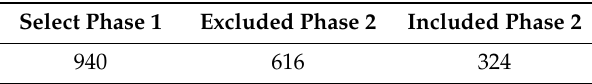
Table 3. Papers selected in phase 2.